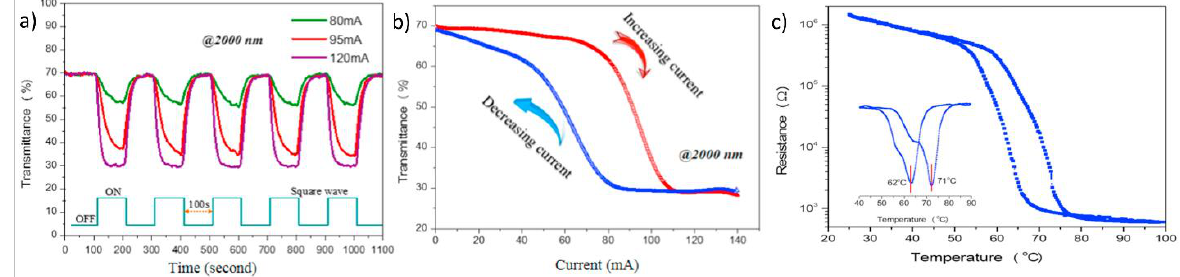
Figure 4. ( a ) Infrared (IR) response of flexible single-walled carbon nanotubes/VO 2 /mica thin film with square-wave current; ( b ) IR performance as a function of applied current (2000 nm); ( c ) Resistance-dependent temperature curve for VO 2 /mica thin film (the inset shows the differential curves during phase transition). Reproduced with permission from [92]. Copyright 2017, Elsevier.